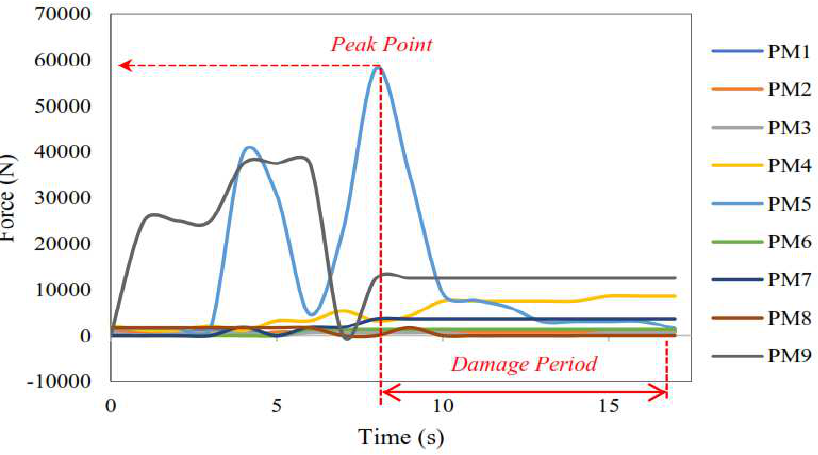
Figure 18. Graph of 2 m reservoir water level test for the frame.